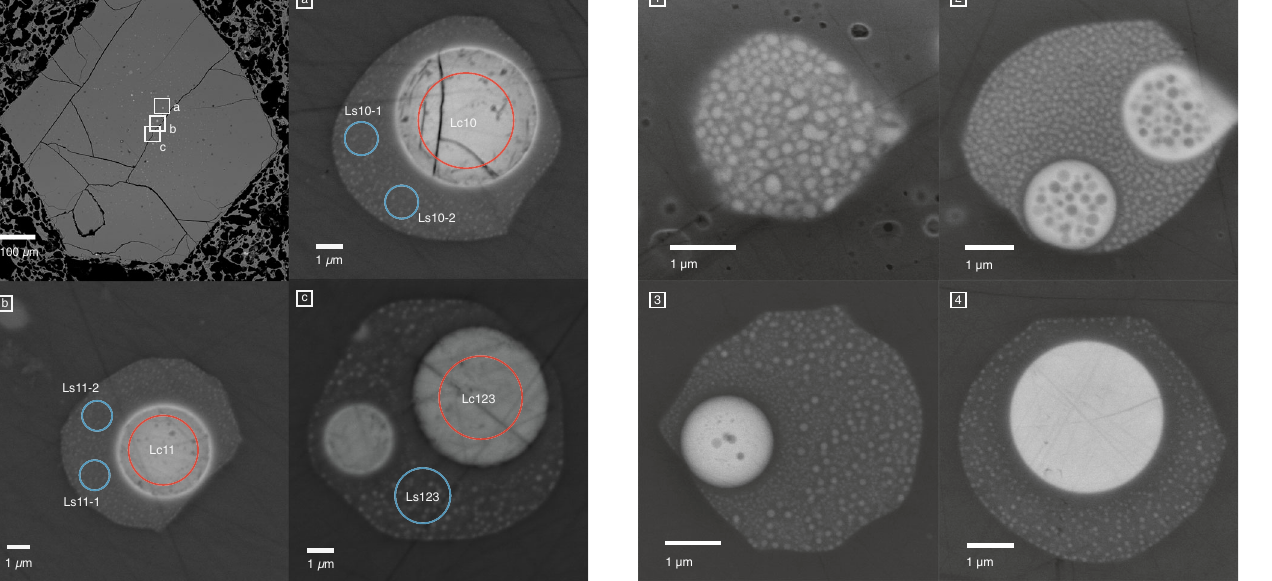
Fig. 1 Conjugate immiscible silicate – carbonate liquids. Back-scattered electron (BSE) images of euhedral hauyne host crystal embedded in phonolitic pumice lapilli from the Laacher See volcano showing melt inclusions ( a – c ) with conjugate immiscible silicate (Ls) and carbonatite (Lc) liquids. Red and blue circles mark EPMA analyses spots. Melt inclusions are larger in the central part of the hauyne host crystals while the outer parts are inclusion-free.